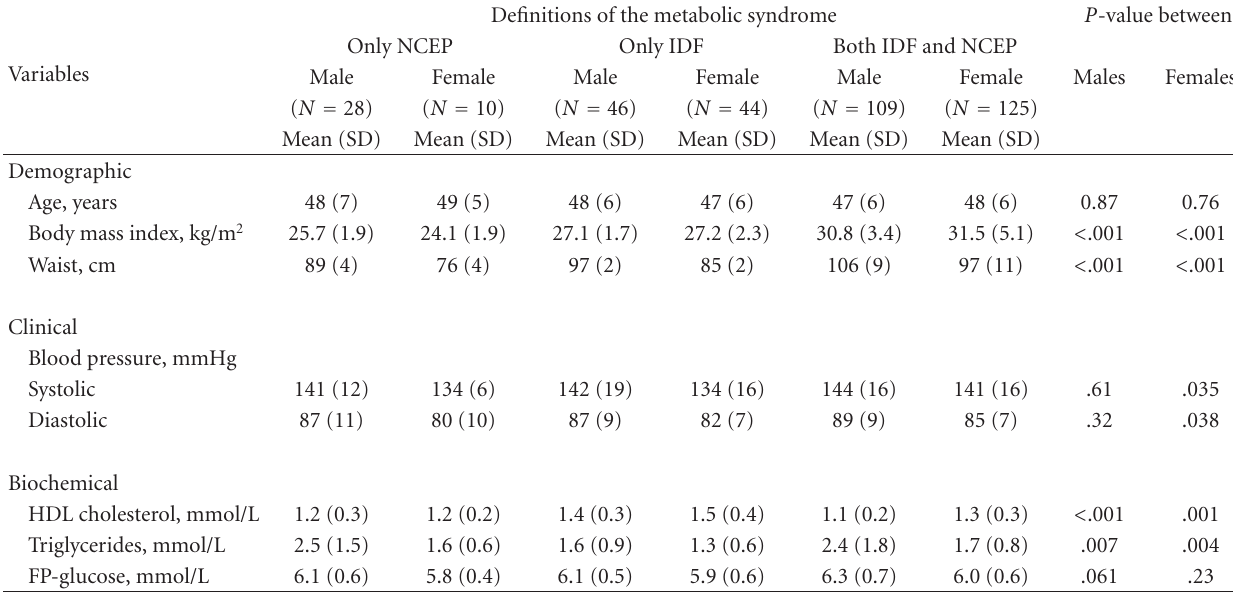
Table 3: Demographic, clinical, and biochemical characteristics of subjects with the metabolic syndrome.